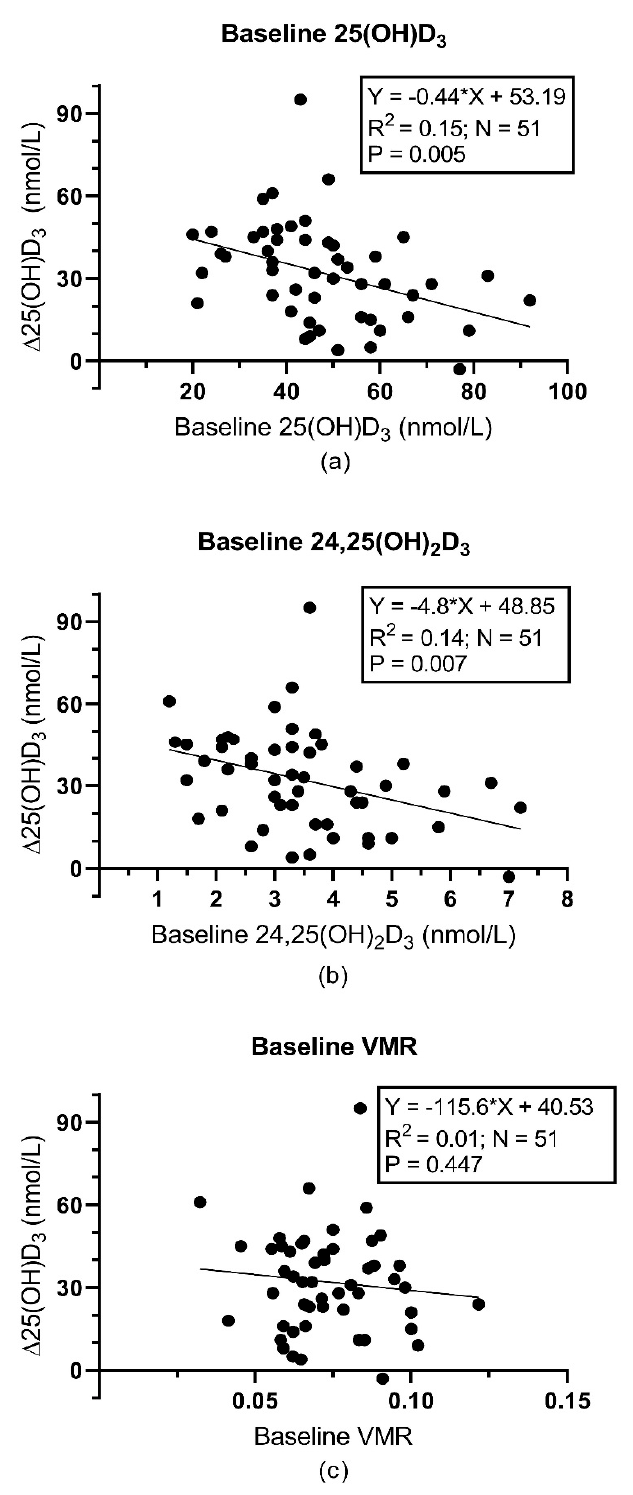
Figure 2. Univariate linear regression analysis for the change in 25(OH)D 3 concentration in the vitamin D intervention group and ( a ) baseline 25(OH)D 3 , ( b ) baseline 24,25(OH) 2 D 3 and ( c ) baseline VMR (Vitamin D Metabolite Ratio).